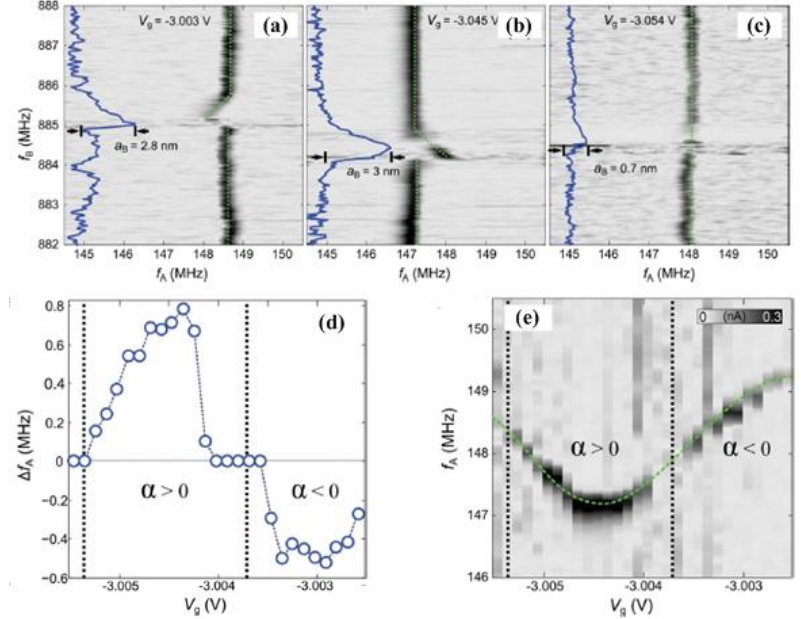
Figure 30. Resonant frequency tuning using the modal interactions reported by Castellanos-Gomez et al . [47]. ( a ) Mode softening; ( b ) mode stiffening; ( c ) modal interaction suppression; ( d ) and ( e ) Frequency tuning by the modal interactions as a function of the gate voltage. Reused with permission from [47], Copyright 2012, American Physical